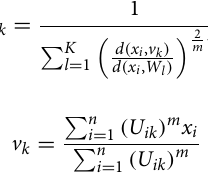
Algorithm should solve U and v 1 , . . . , v K by minimizing Eqs. (8 and 9).